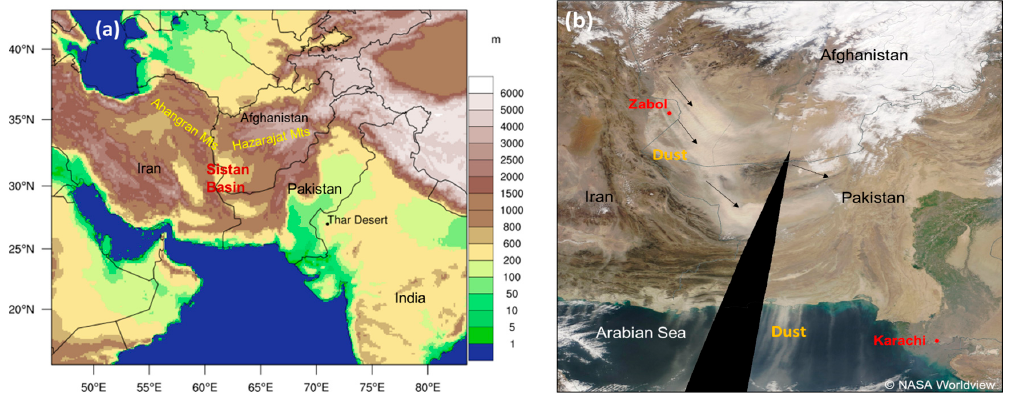
Figure 1. ( a ) Topography map of the study area and surrounding countries with the terrain elevation map. ( b ) The dust outbreak over Sistan on 6 February 2019 as seen from Terra Moderate Resolution Imaging Spectroradiometer (MODIS) visible imagery. Image credit: NASA